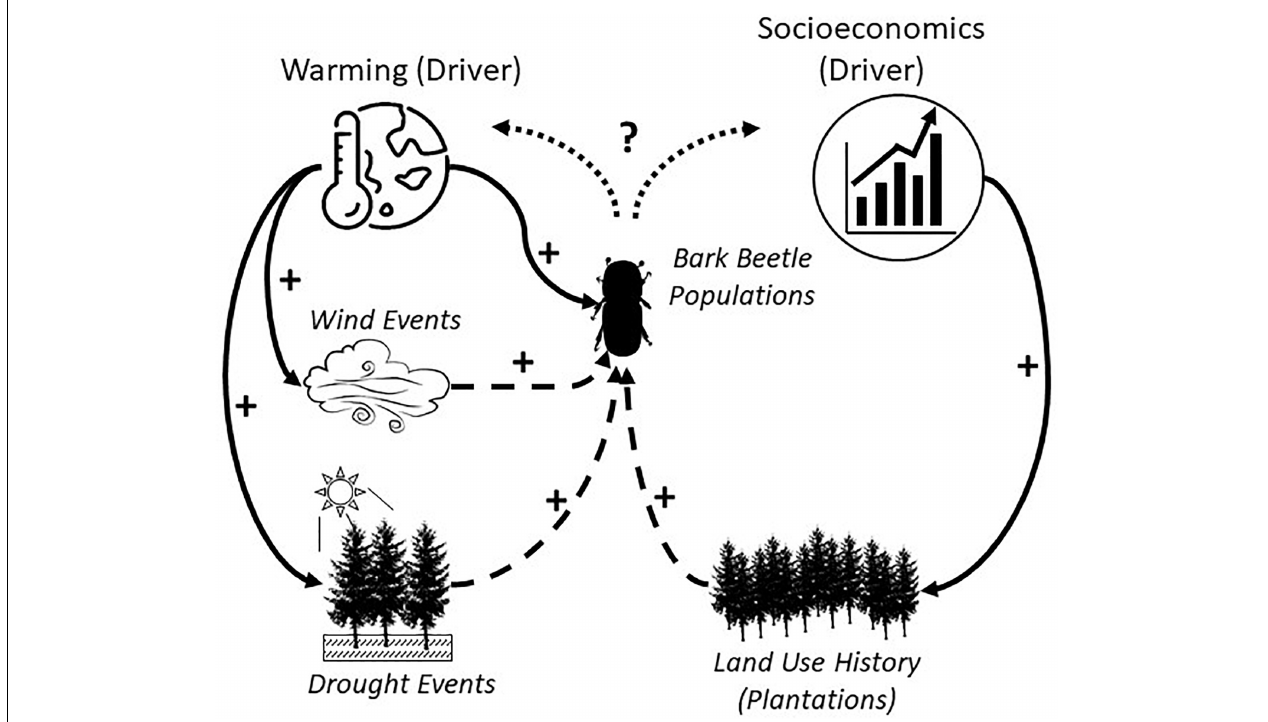
FIGURE 6 | Direct and indirect interactions of disturbances and drivers contributing to the amplification of a disturbance agent, illustrated using the European spruce beetle example from central Europe (see Section “Cross-Scale